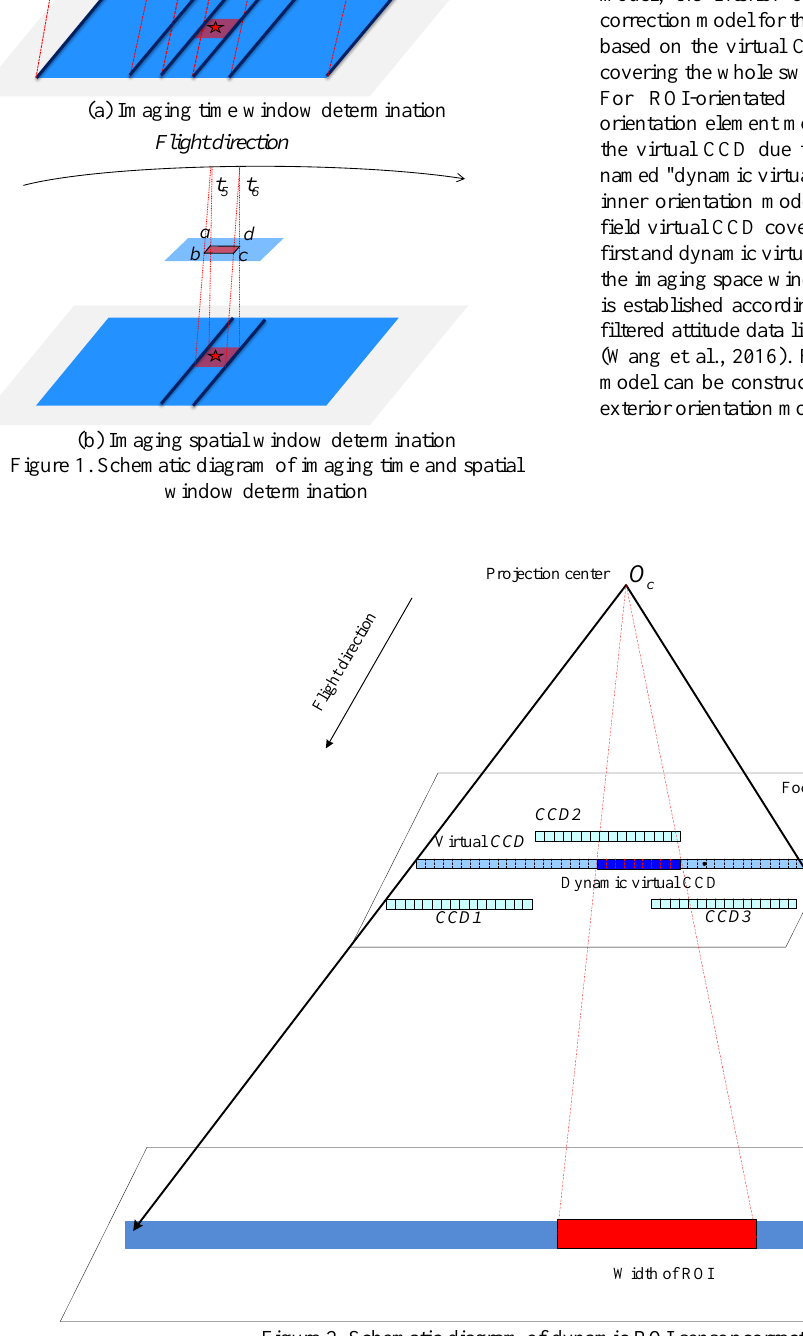
Figure 2. Schematic diagram of dynamic ROI sensor correction